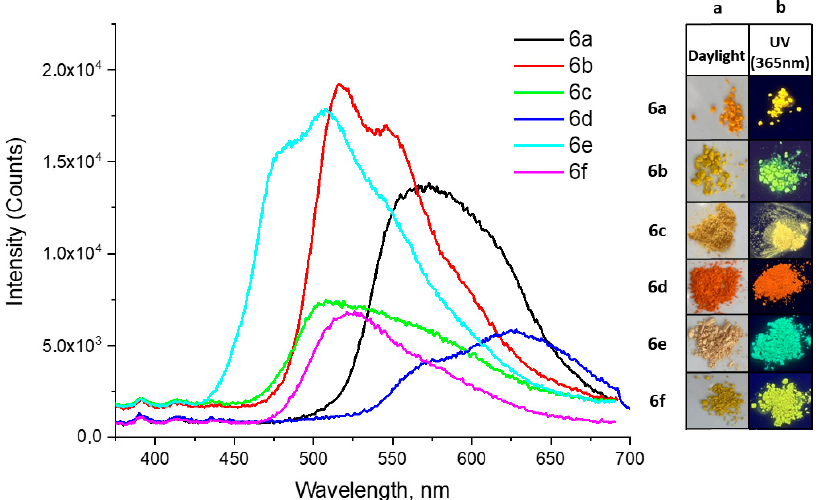
Figure 3. Emission spectra of dyes 6a – f in powders ( a ) and photographs of the solid samples under daylight and 365 nm UV irradiation ( b ).